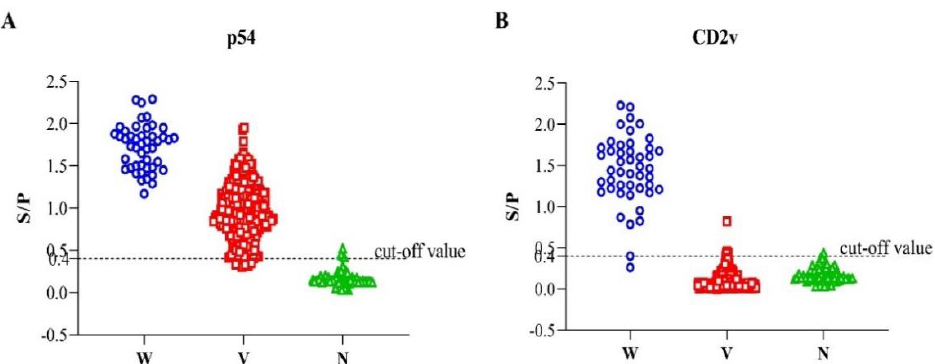
Figure 4. Interactive dot diagram of the dual indirect ELISA; p54-ELISA ( A ) and CD2v-ELISA ( B ) via Graph Pad Prism version 8.0.2. (GraphPad Software Inc., La Jolla, CA, USA). In the graph, the data of positive and negative samples are displayed as dots on three vertical axes (W = sera from experimental infection with wild-type ASFV (HLJ/18); V = immunological sera from pigs vaccinated with the seven-gene-deleted attenuated ASFV vaccine (HLJ/18-7GD) and N = ASFV-seronegative). The seven-gene-deleted live attenuated ASF vaccine candidate HLJ/18-7GD lacks EP402R-gene-encoding CD2v protein, so serum samples collected after immunizing